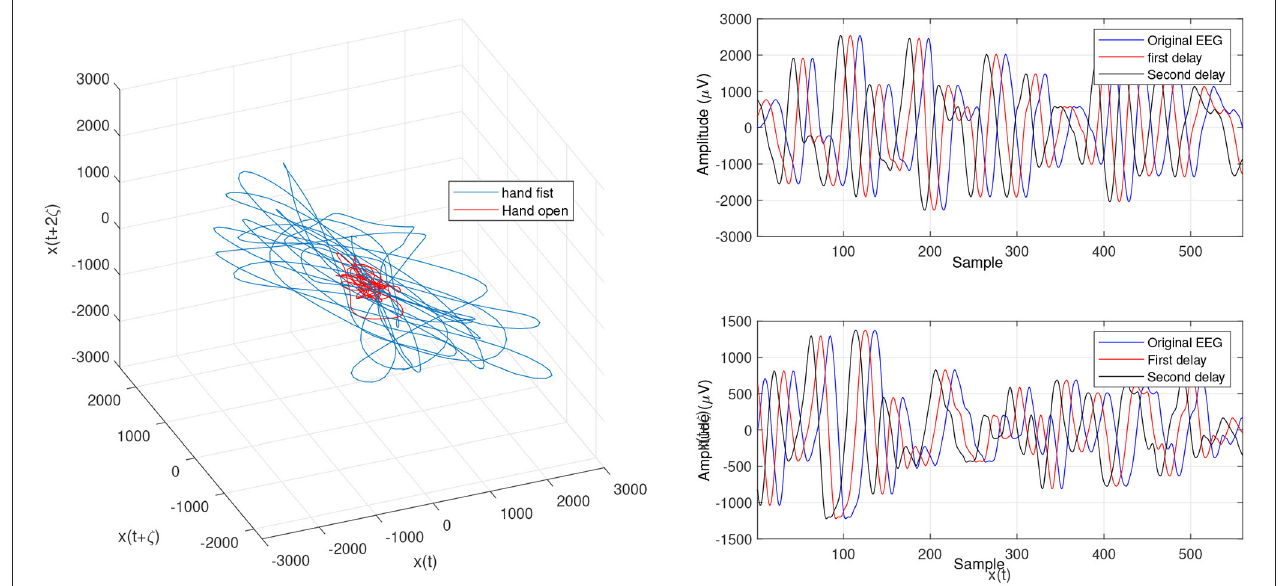
FIGURE 9 | Changed projection of trajectories for an open hand and making a fist by using the OLLE in the reconstructed phase space based on the CTW for channel C3.